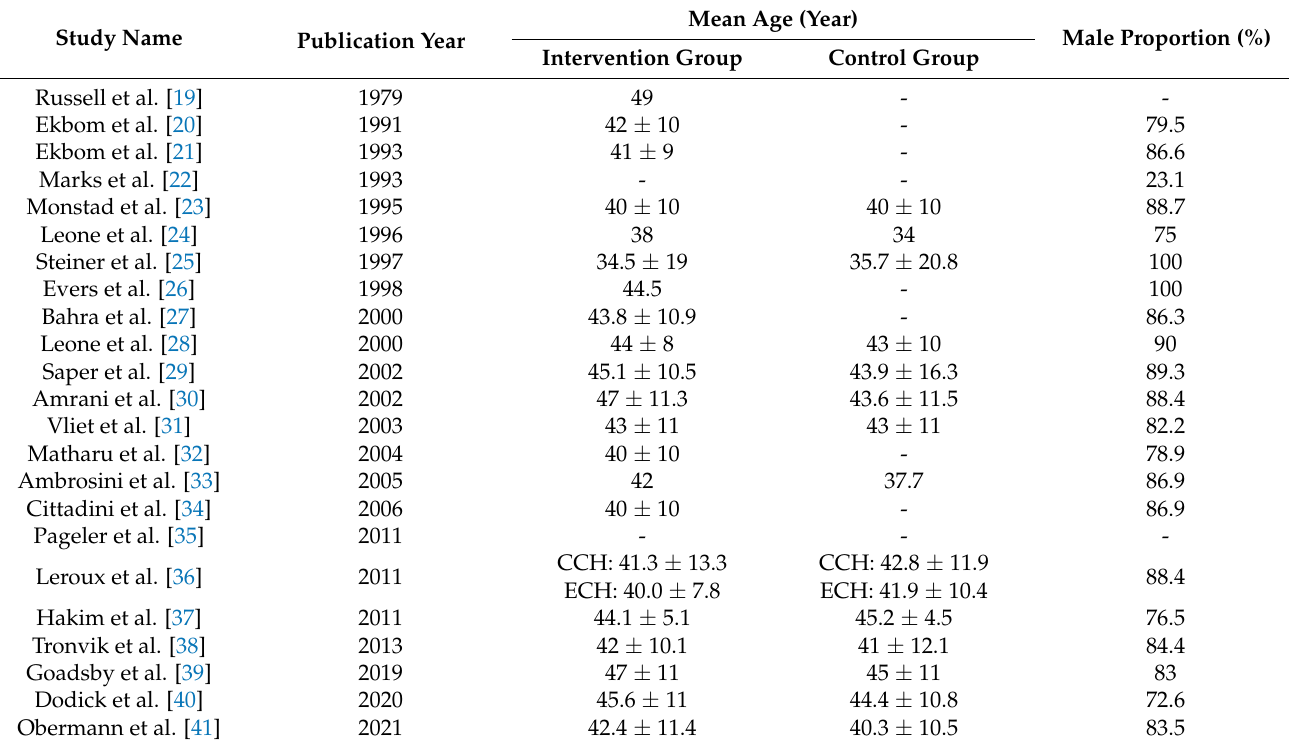
Table 2. Baseline characteristics of age and male